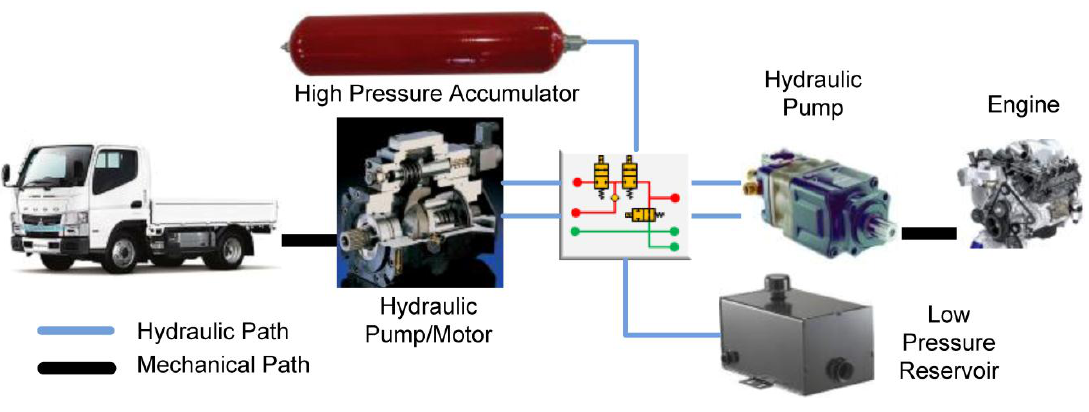
Figure 1. Schematic of a series hydraulic hybrid